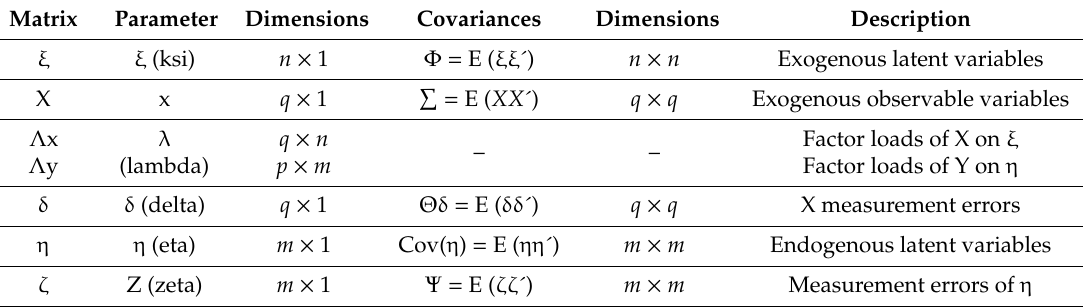
Table 1. Description of the Matrices in the CFA Model of 1st Order and 2nd